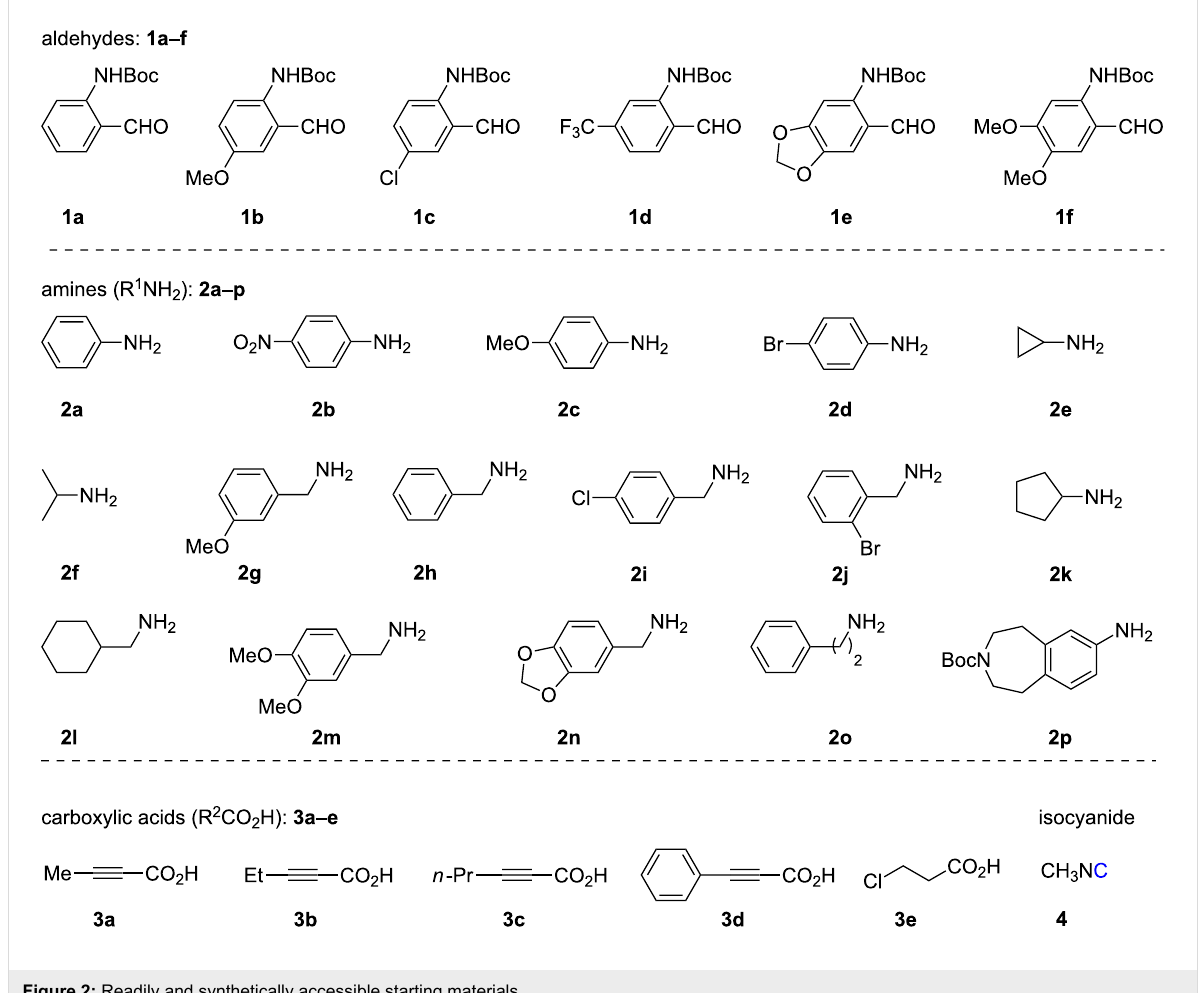
Figure 2: Readily and synthetically accessible starting